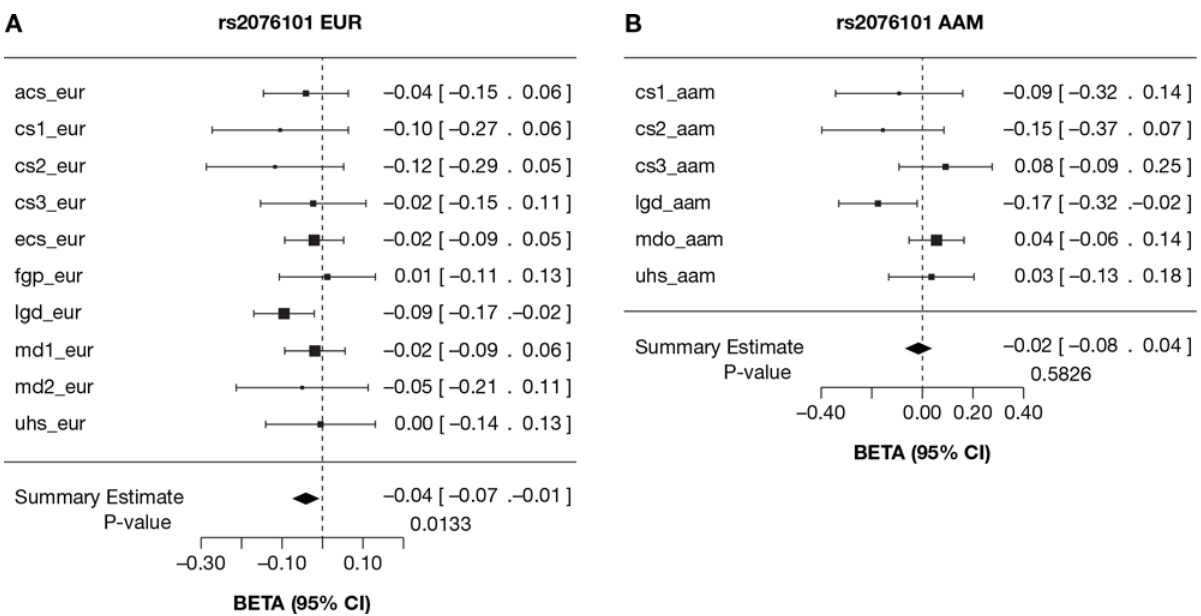
Fig 3. HIV-1 viral load levels of A3F 231V allele carriers in multiple HIV-1 cohorts. Forest plot of effect estimates of HIV-1 viral load for the A3F rs2076101 G allele with 95% confidence intervals per study group (box and whiskers) and after meta-analysis (diamond) in the International Collaboration for the Genomics of HIV (ICGH) consortium [36]. (A) Meta-analyses for European or European-descents (eur). (B) Meta-analyses for African Americans (aam). A description of the study groups and cohorts used in the meta-analysis is presented in S3 Table.